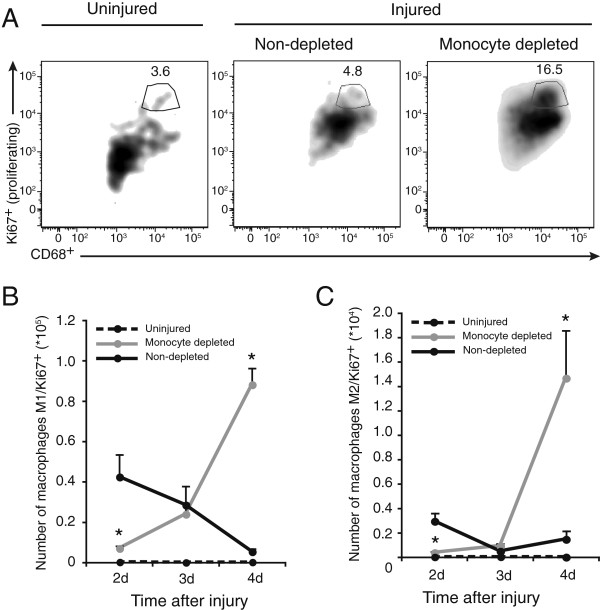
Monocyte depletion induced significant increase in the number of proliferative macrophages in injured TA muscles. Rats were treated once a day with intravenous injection of liposome-encapsulated clodronate starting 24 h prior to injury until euthanasia at 2, 3 and 4 d post-injury for analysis of the number of proliferating Ki-67+M1 and Ki-67+M2 macrophages into injured muscle. (A) Total CD11b+CD68+ proliferating macrophages also positive for Ki-67+ (not shown) were identified. Gates were set using isotype controls for Ki-67 and CD68. (B) Ki-67+M1 and (C) Ki-67+M2 macrophage subsets were quantified at 2, 3 and 4 d post-injury. Liposome-encapsulated clodronate induced a significant increase of Ki-67+M1 and Ki-67+M2 macrophage numbers at 4 d post-injury. *Significantly different from non-depleted groups, Student’s t-test, p < 0.05. n = at least 4, for all the time points and conditions evaluated.